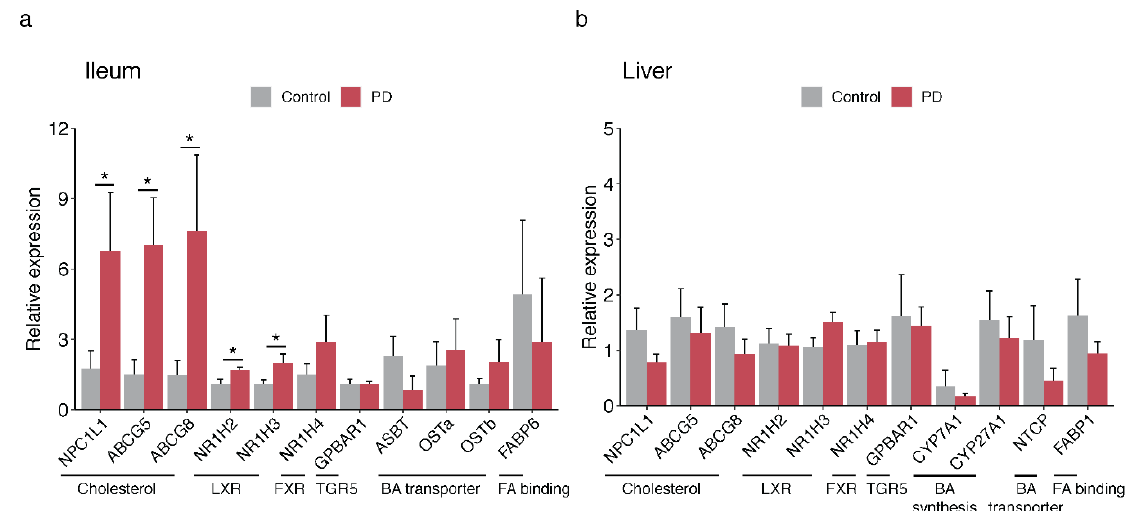
Figure 4. Dysfunctional cholesterol and lipid metabolism in the PD ileum. Transcript levels of genes in the ileum ( a ) and liver ( b ) affecting the abundance of cholesterol and bile in the enterohepatic circulation. Transcript levels of genes affecting cholesterol and bile acid homeostasis ( NR1H2 , NR1H3 , NR1H4 , GPBAR1 ) and their transport and reabsorption into the enterohepatic circulation ( NPC1L1 , ABCG5 , ABCG8 , ASBT , OSTα , OSTβ , FABP6 ) were examined in the ileum. In the liver, the transcript levels of these genes or the equivalent bile acid transporters ( NTCP , FABP1 ) were examined, as well as the rate-limiting enzymes for bile acid production ( CYP7A1 , CYP27A1 ). Transcript levels were analyzed by qPCR and normalized to housekeeping genes ( villin1 , β-actin ). The relative expression ± s.e.m in the ileum ( n = 8 PD, 6 controls) and liver ( n = 6 PD, 6 controls). * p < 0.05, one-way ANOVA.